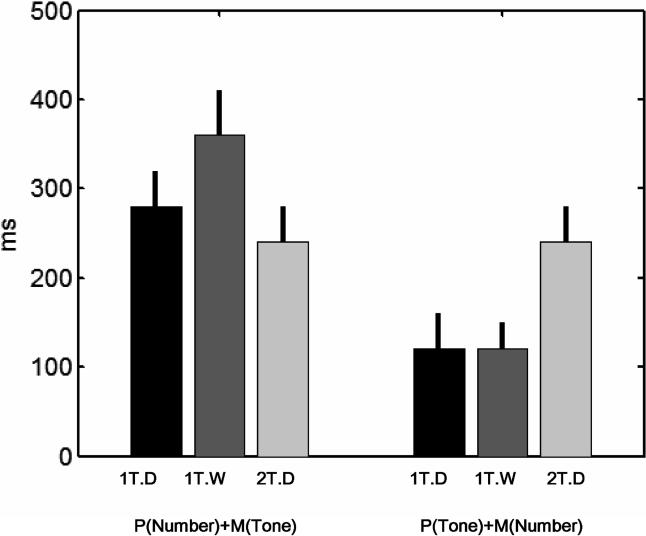
Parameters Obtained from the PRP Fitting and Their Task DependenceThe PRP fitting allowed us to estimate the values of P2 + M1. Depending on which task is presented first, we can calculate P(Number) + M(Tone) (left bars) or P(Tone) + M(Number) (right bars). P(Number) + M(Tone) changes with notation manipulation but not with response manipulation. Conversely, P(Tone) + M(Number) changes with response manipulation but not with the notation manipulation. Furthermore, the left bars are consistently higher than the right bars, suggesting that visual perception of digits and words takes approximately 150–220 ms longer than auditory perception of a single tone.